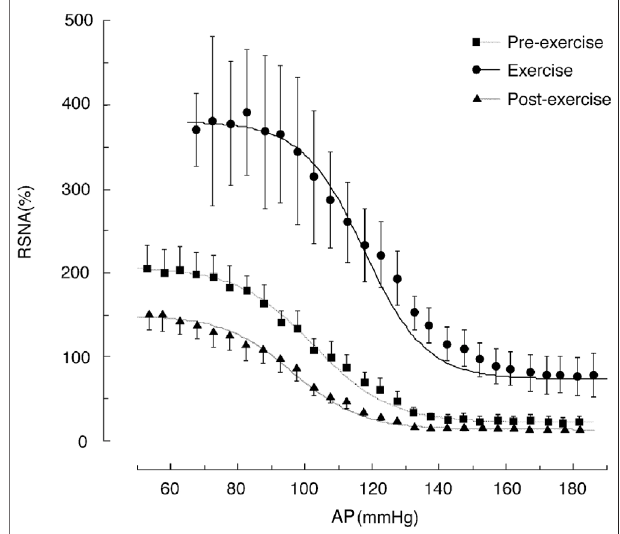
FIGURE 4 | Shifts in the barore fl ex curves for renal sympathetic nerve activity (RSNA) during the pre-exercise, treadmill exercise, and post-exercise periods. The average oxygen consumption during treadmill exercise at a speed of 20 m/min with a 0% gradient performed in this study was 51 ml/min/kg, which was approximately 70% of the maximum oxygen consumption. The curves and bars indicate the mean and standard error of the mean, respectively, estimated over each 2.5-mmHg bin of arterial pressure(AP).TheimagewasobtainedwithpermissionfromthestudybyMiki et al.